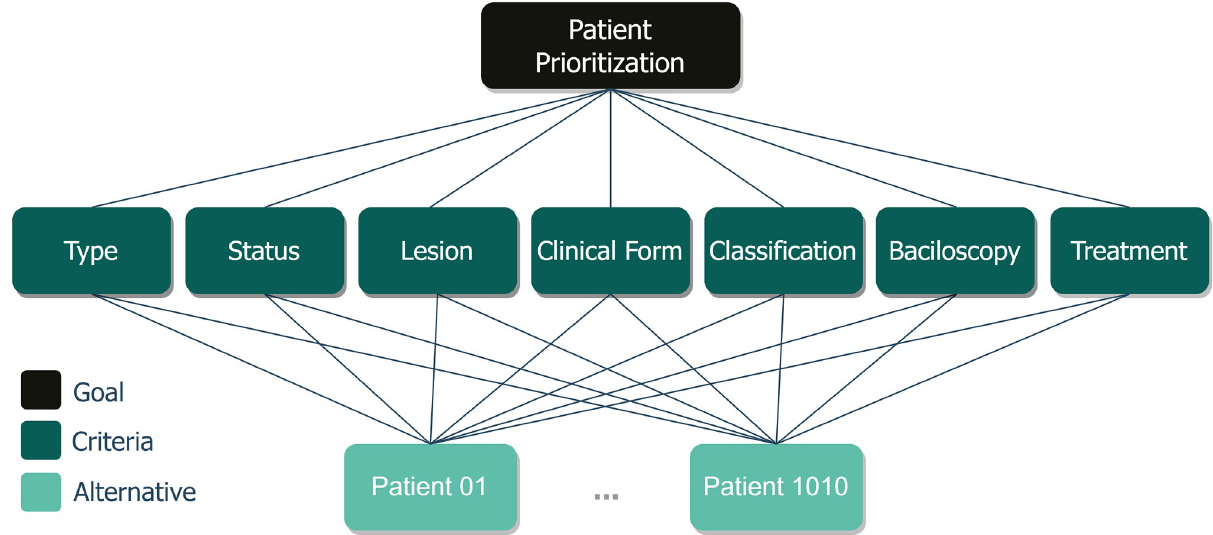
Fig 3. Hierarchy of criteria/objectives. The figure shows the basic hierarchical structure of the AHP method.